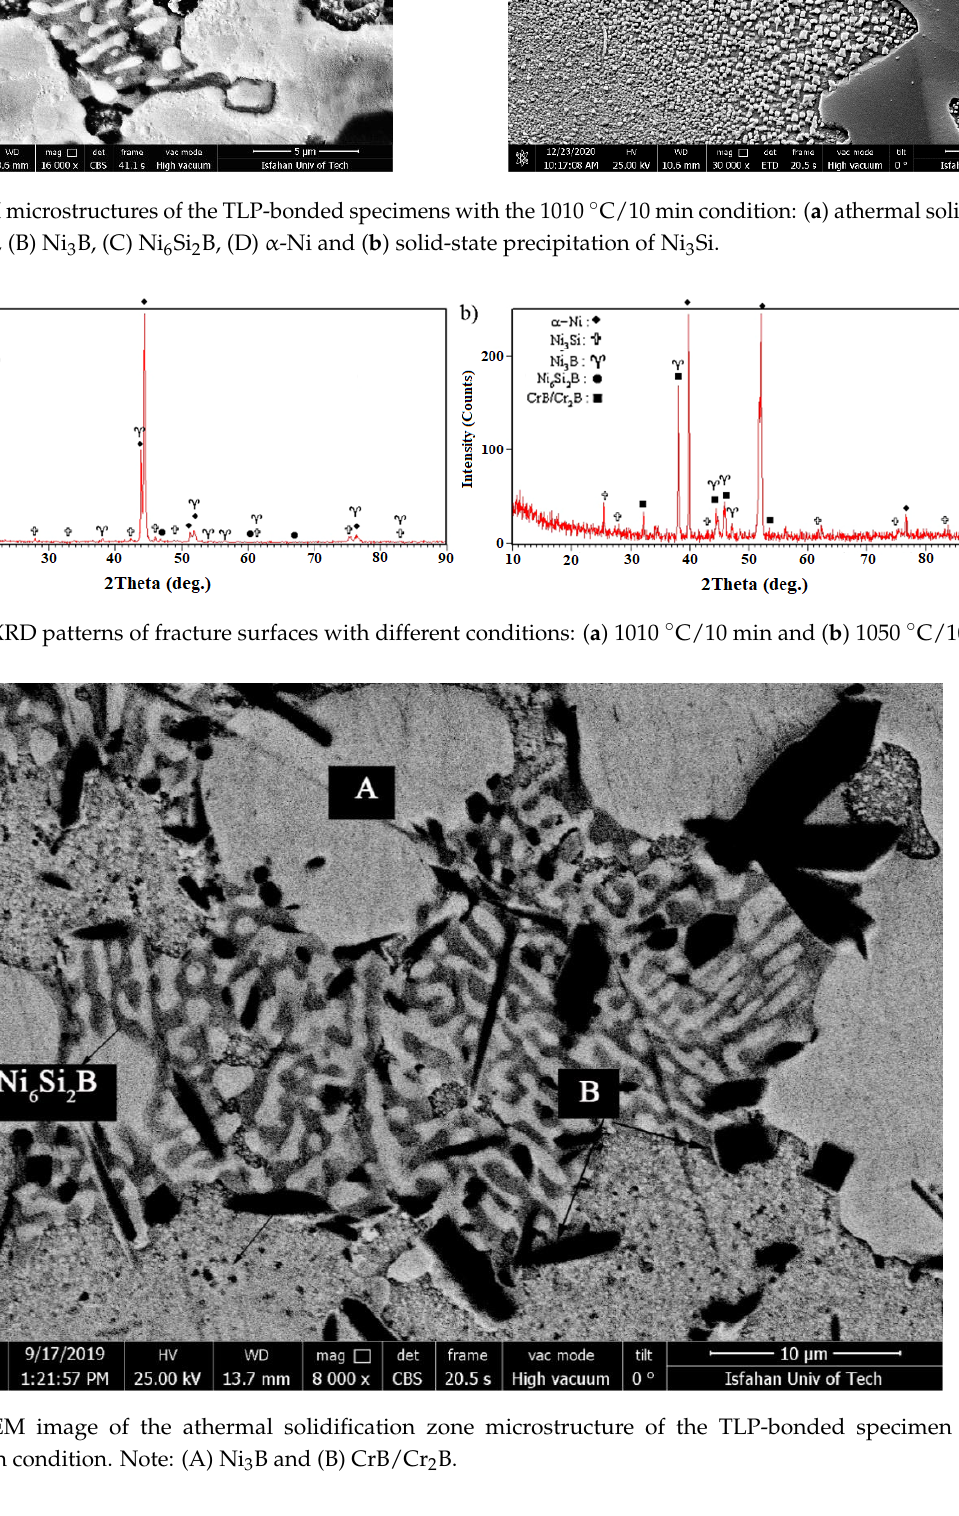
Figure 14. SEM microstructures of the TLP-bonded specimens with the 1010 °C/10 min condition: ( a ) athermal solidifica- tion zone: (A) Ni 3 B, (B) Ni 3 B, (C) Ni 6 Si 2 B, ( D) α -Ni and ( b ) solid-state precipitation of Ni 3 Si. Table 5. EDX analysis of various phases indicated in Figure 14 (wt. %).